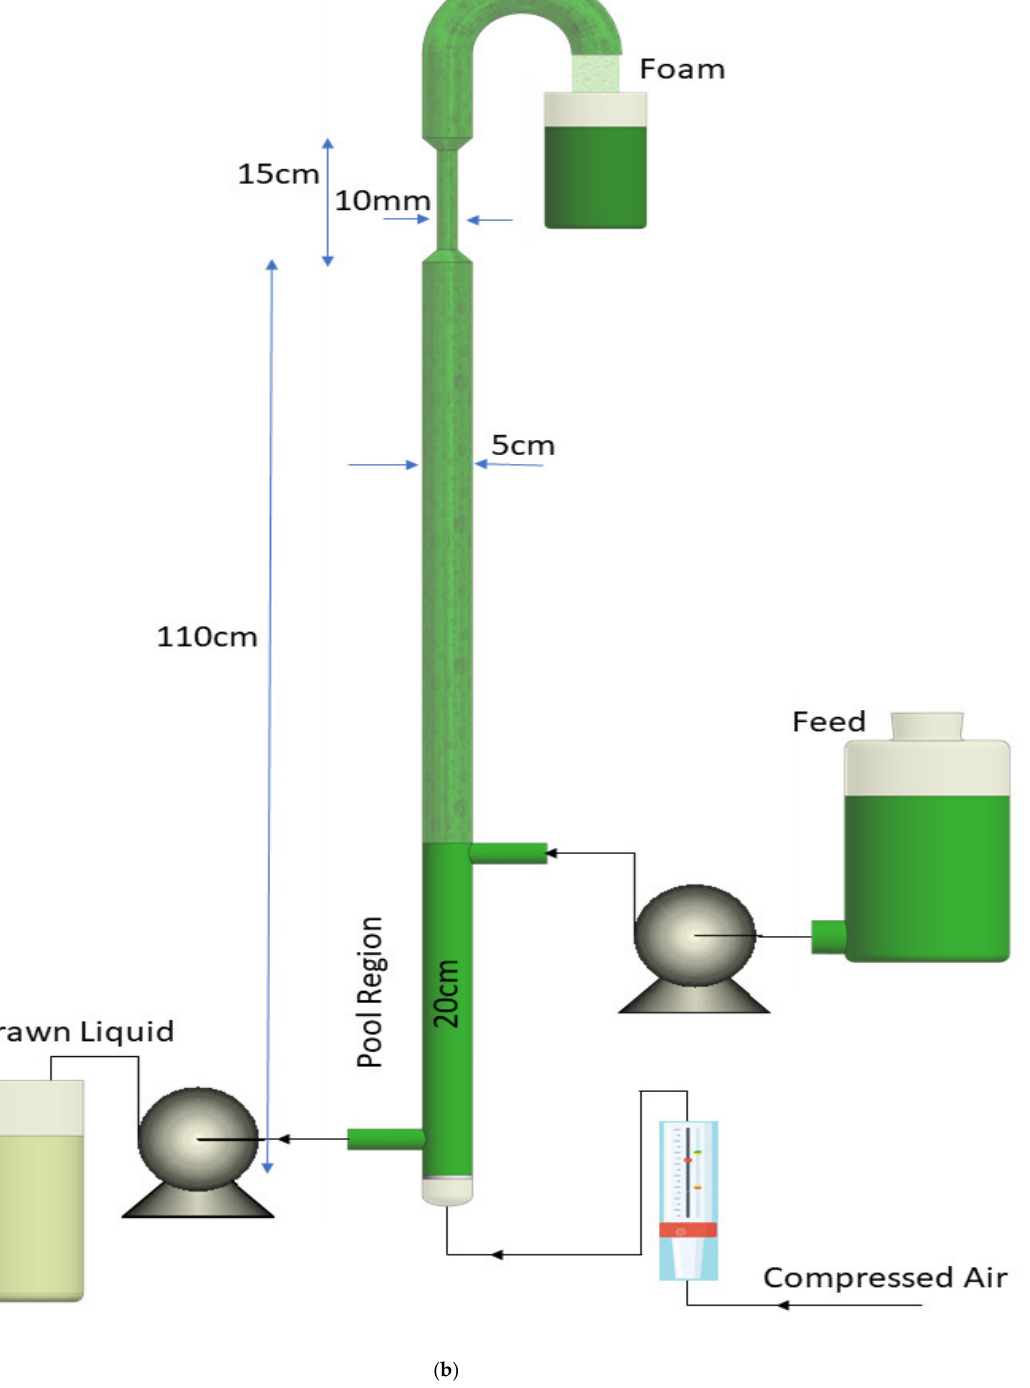
Figure 1. System to prepare chlorella vulgaris algae for reactive extraction. ( a ) photo of dispersed air flotation apparatus with foam assistance(rising) and ( b ) sketch of flotation rig .